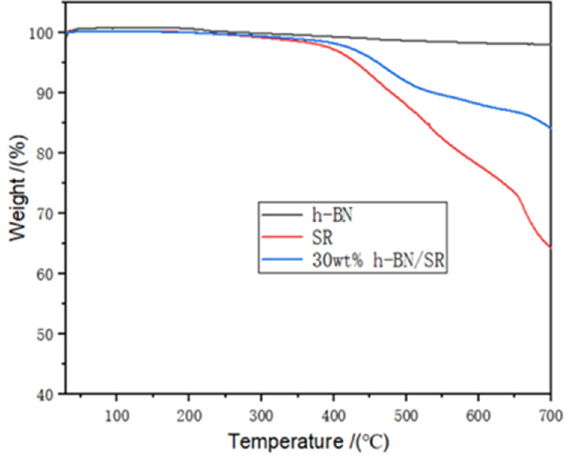
Figure 7. TGA curves of h-BN, SR, and h-BN/SR composite.